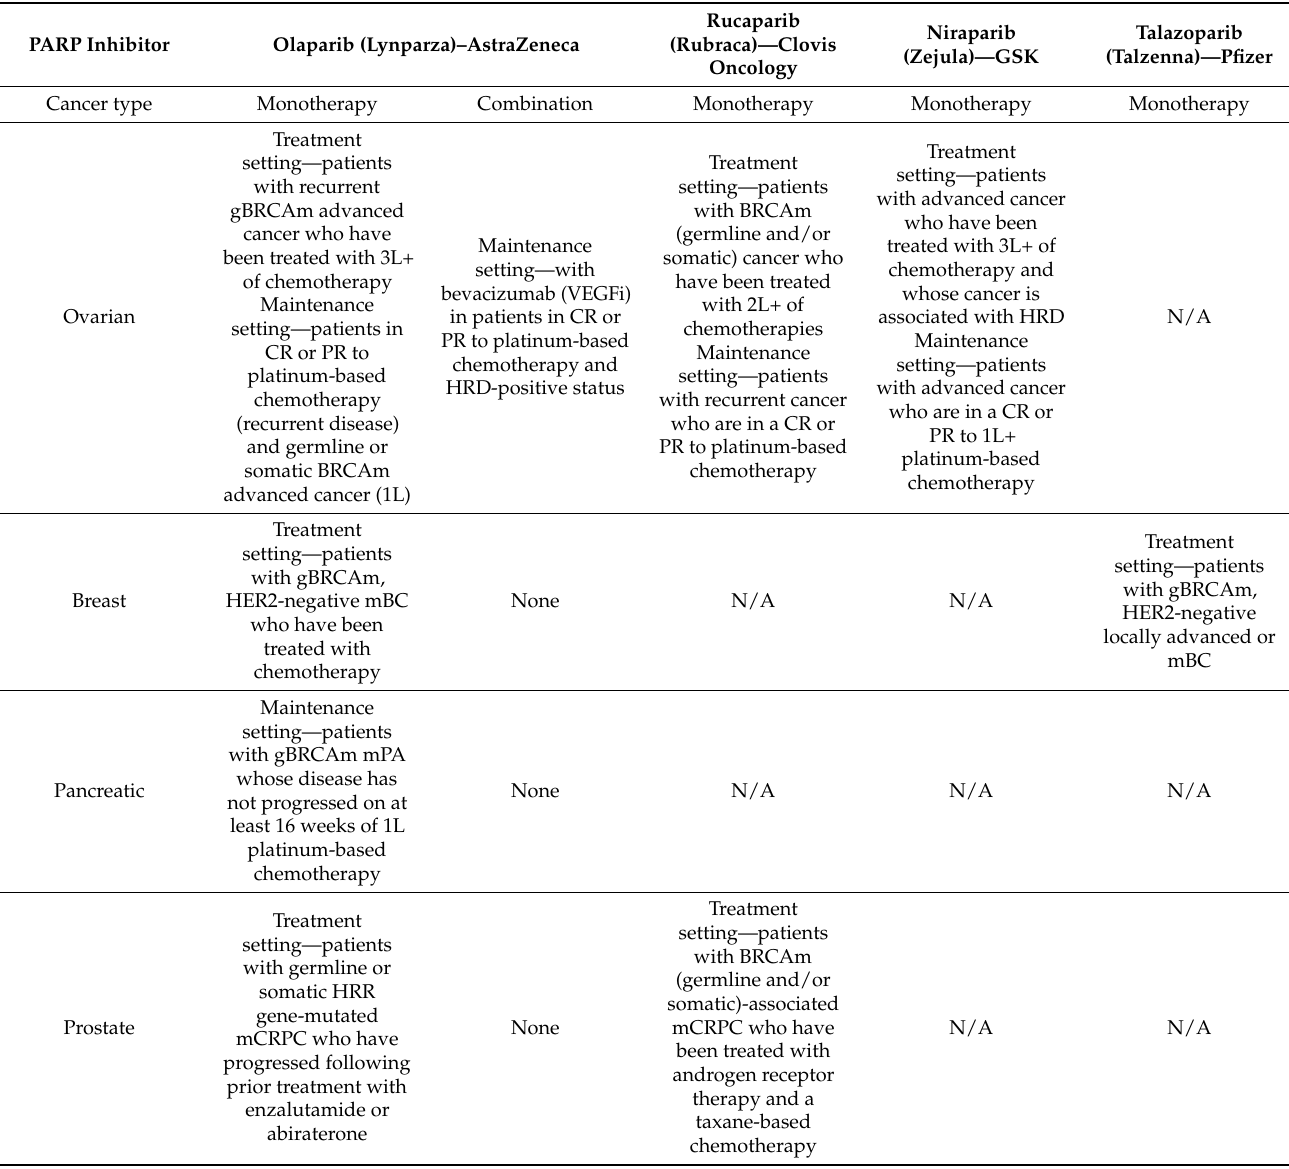
Table 1. US Food and Drug Administration labels for different